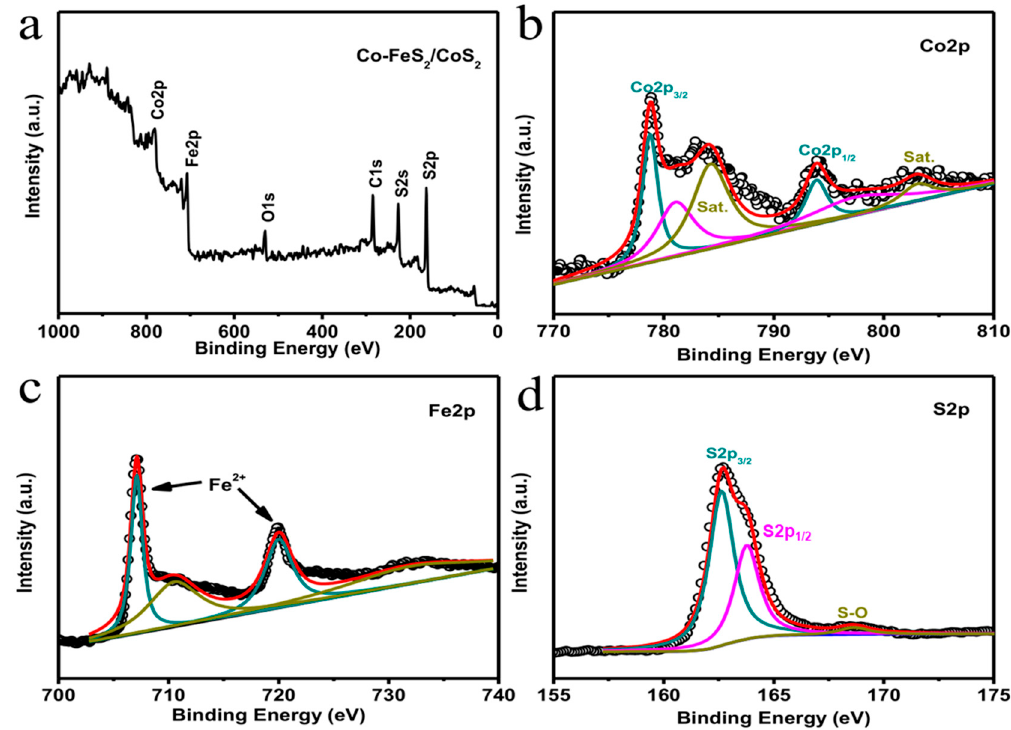
Figure 2. XPS spectra of Co-FeS 2 /CoS 2 heterostructure: ( a ) survey spectrum, and high-resolution, ( b ) Co 2p, ( c ) Fe 2p, ( d ) S 2p spectrum.